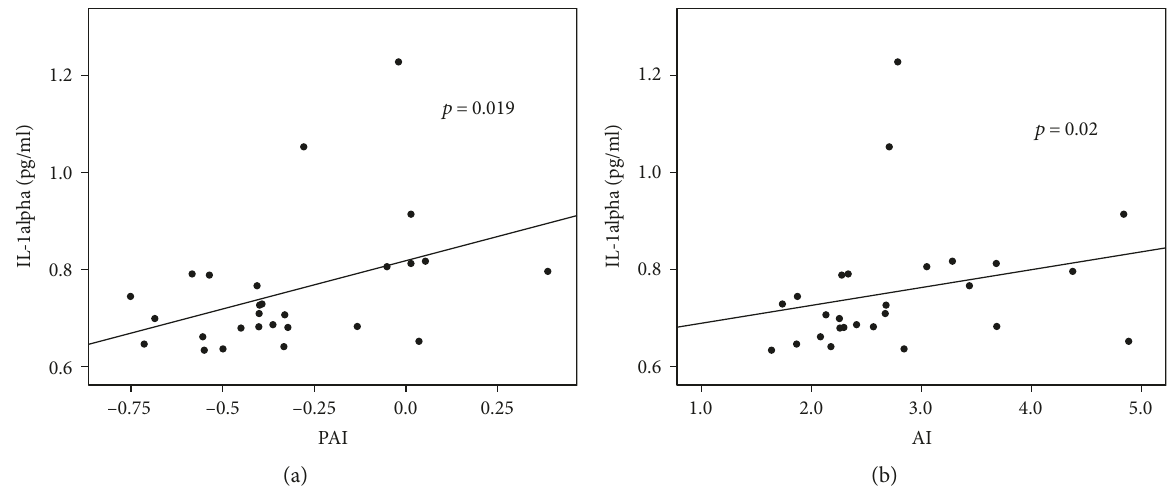
Figure 3: In fl ammatory cytokines and calculated lipid indexes. Patients with higher calculated PAI and AI lipid indexes exhibited a signi fi cantly higher production of proin fl ammatory cytokine IL-1alpha ( p = 0 019 and R = 0 449 for PAI and p = 0 02 and R = 0 446 for AI, resp.). (a) IL-1alpha and PAI (plasma atherogenic index). (b) IL-1alpha and AI (atherogenic